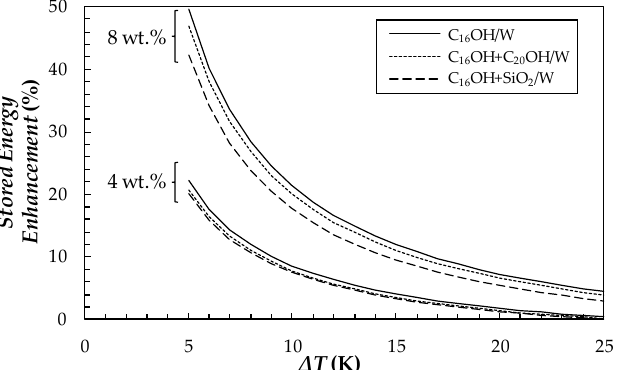
Figure 4. Enhancements in the stored thermal energy vs. temperature interval covered by nanoemulsion, Δ T .